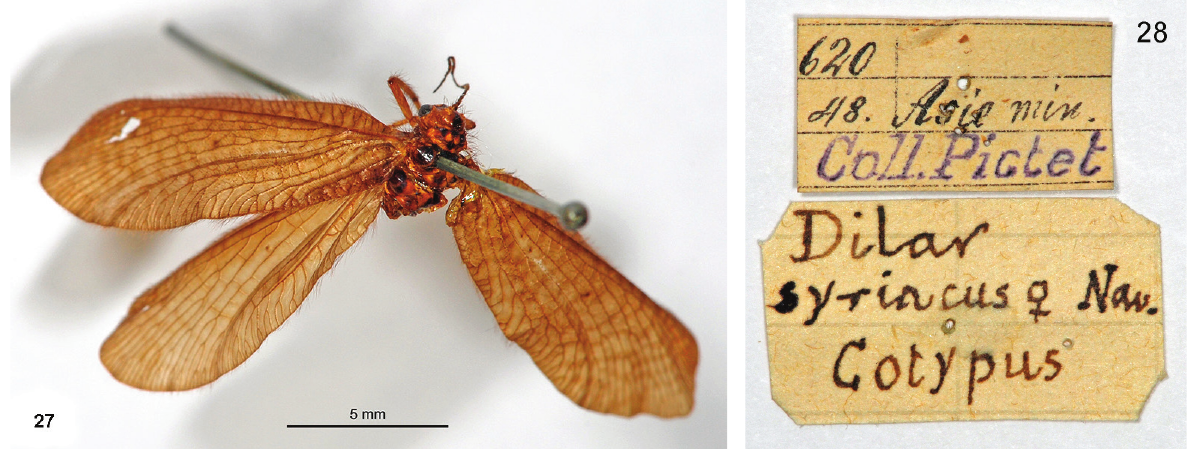
Figures 27–28. Dilar fuscus sp. n., paratype, female (MHN, Genéve). 27. Habitus; 28. Labels. [The label “Dilar syriacus Nav. ♀, Cotypus” is wrong].